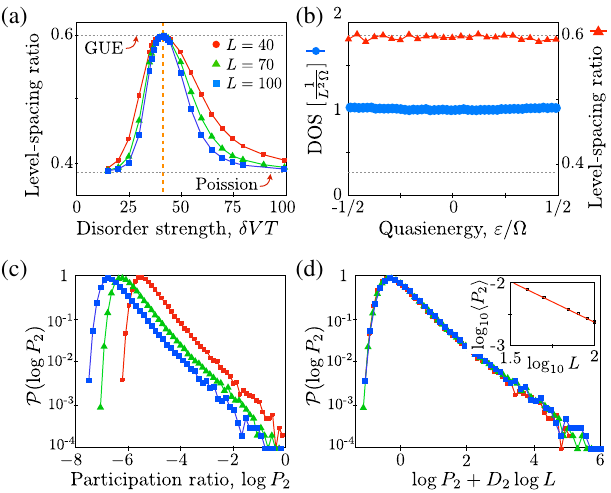
FIG. 7. Transition from the AFAI into a trivial phase at strong disorder. (a) Average level-spacing ratio as a function of disorder strength. On increasing disorder strength, a transition is observed between two localized phases with delocalized levels at δ VT ≈ 40 . Here, the level-spacing ratio is averaged over all quasienergies. (b) Level-spacing ratio as a function of quasie- nergy and its comparison with the DOS, indicating that the entire Floquet band is delocalized. (c) Effect of finite size on the distribution of the participation ratio P 2 at a given disorder strength, δ VT ¼ 40 . The system sizes we use for the simulations are L x × L y ¼ 40 × 40 , 70 × 70 , 100 × 100 . The shape of the curve does not change, indicating a critical phase. (d) Scaling collapse of the three curves with D 2 ¼ 1 . 3 . For the critical phase it is expected that h P 2 i ∼ L − D 2 . This is confirmed in the inset pation ratio h P 2 i . The fractal dimension D 2 is extracted from the slope of the linear